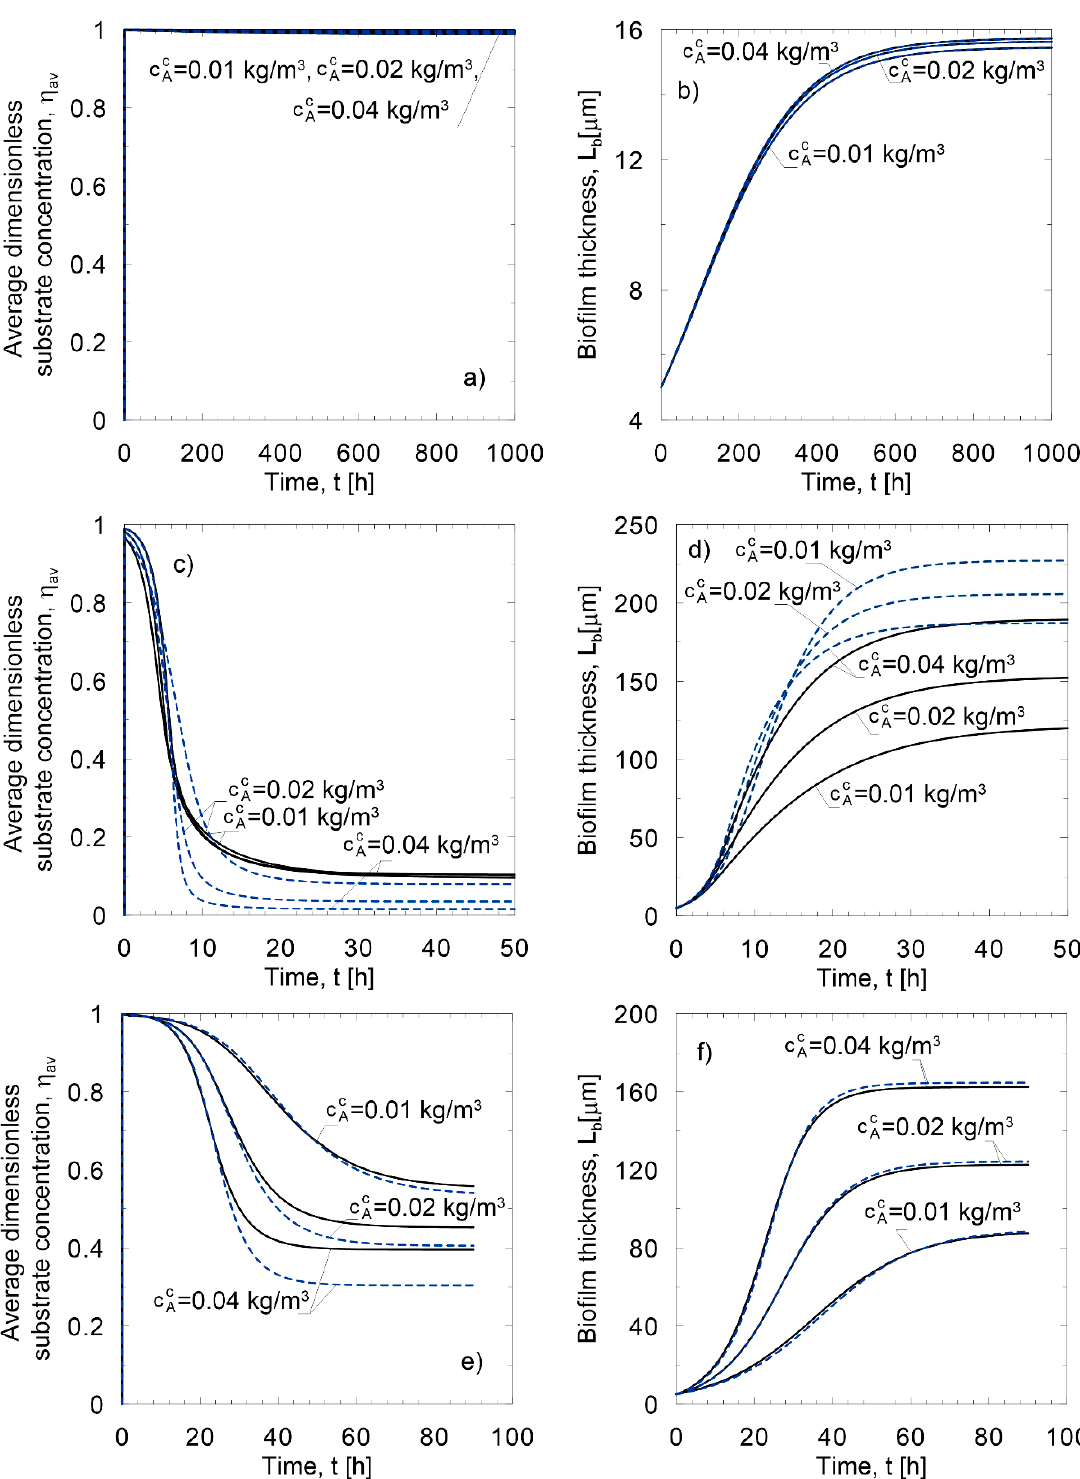
Figure 5. Comparison of average dimensionless substrate concentration (left column), biofilm thickness obtained in the dynamical simulation of biofilm growth with the use of the exact model (solid lines) and approximate model AM1 (dashed lines); ( a , b ) nitrite oxidation by nitrifying bacteria; ( c , d ) glucose utilization by Pseudomonas aeruginosa ; ( e , f ) phenol degradation by Pseudomonas putida .